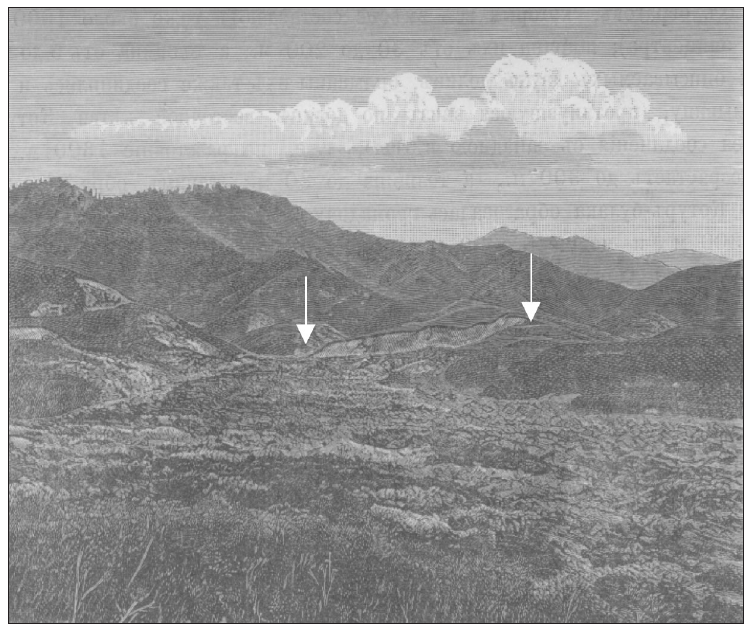
Fig. 3. Example of documenting macroseismic effects on natural environment (photo from Mushketov, 1890). Arrows point the edges of the